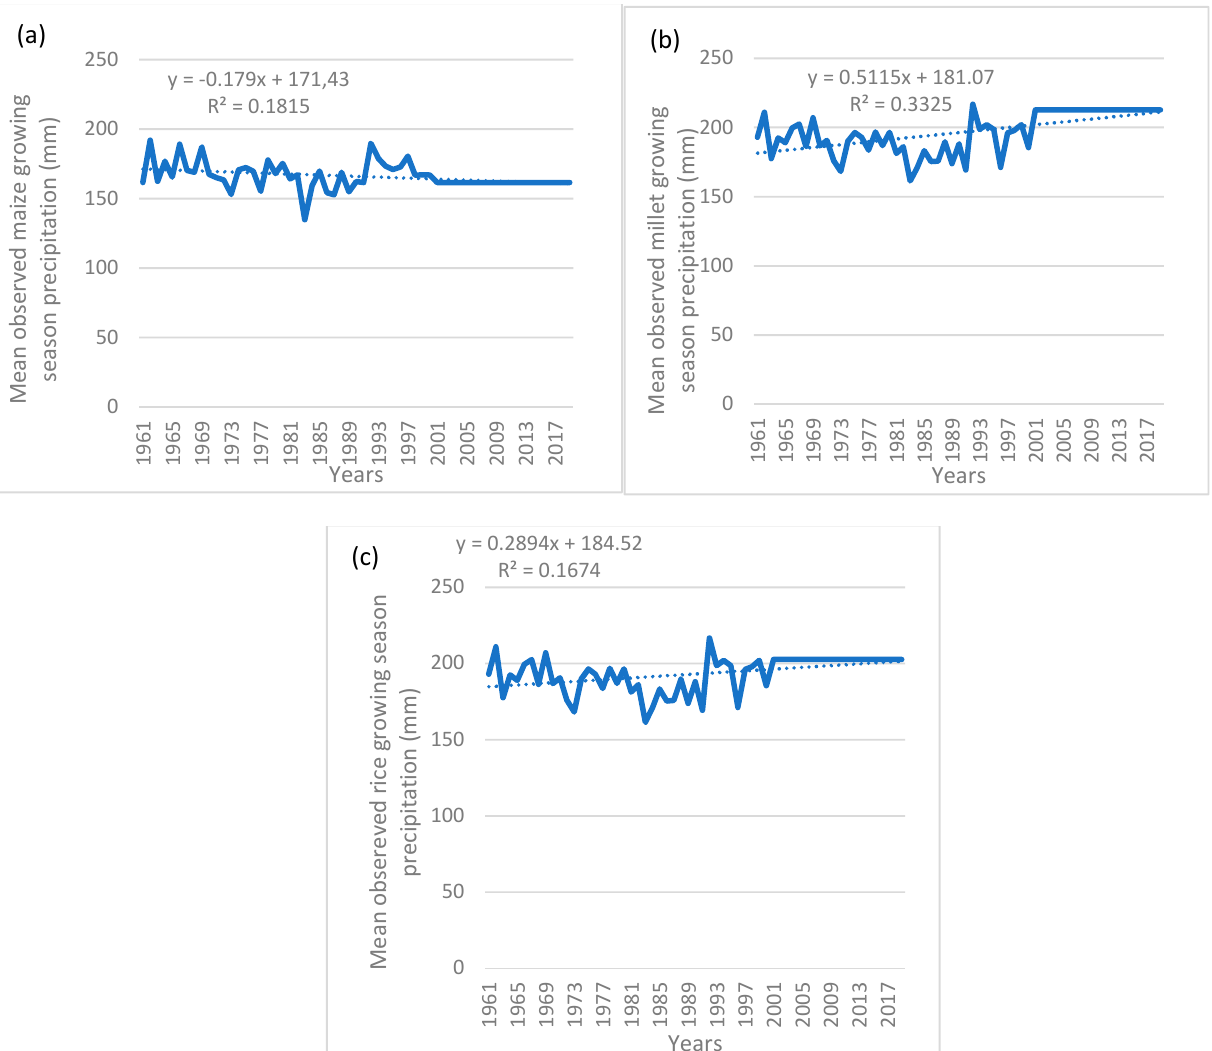
Figure 5. Growing Season Precipitation at a National Scale for (a) Maize, (b) Millet and (c) Rice.